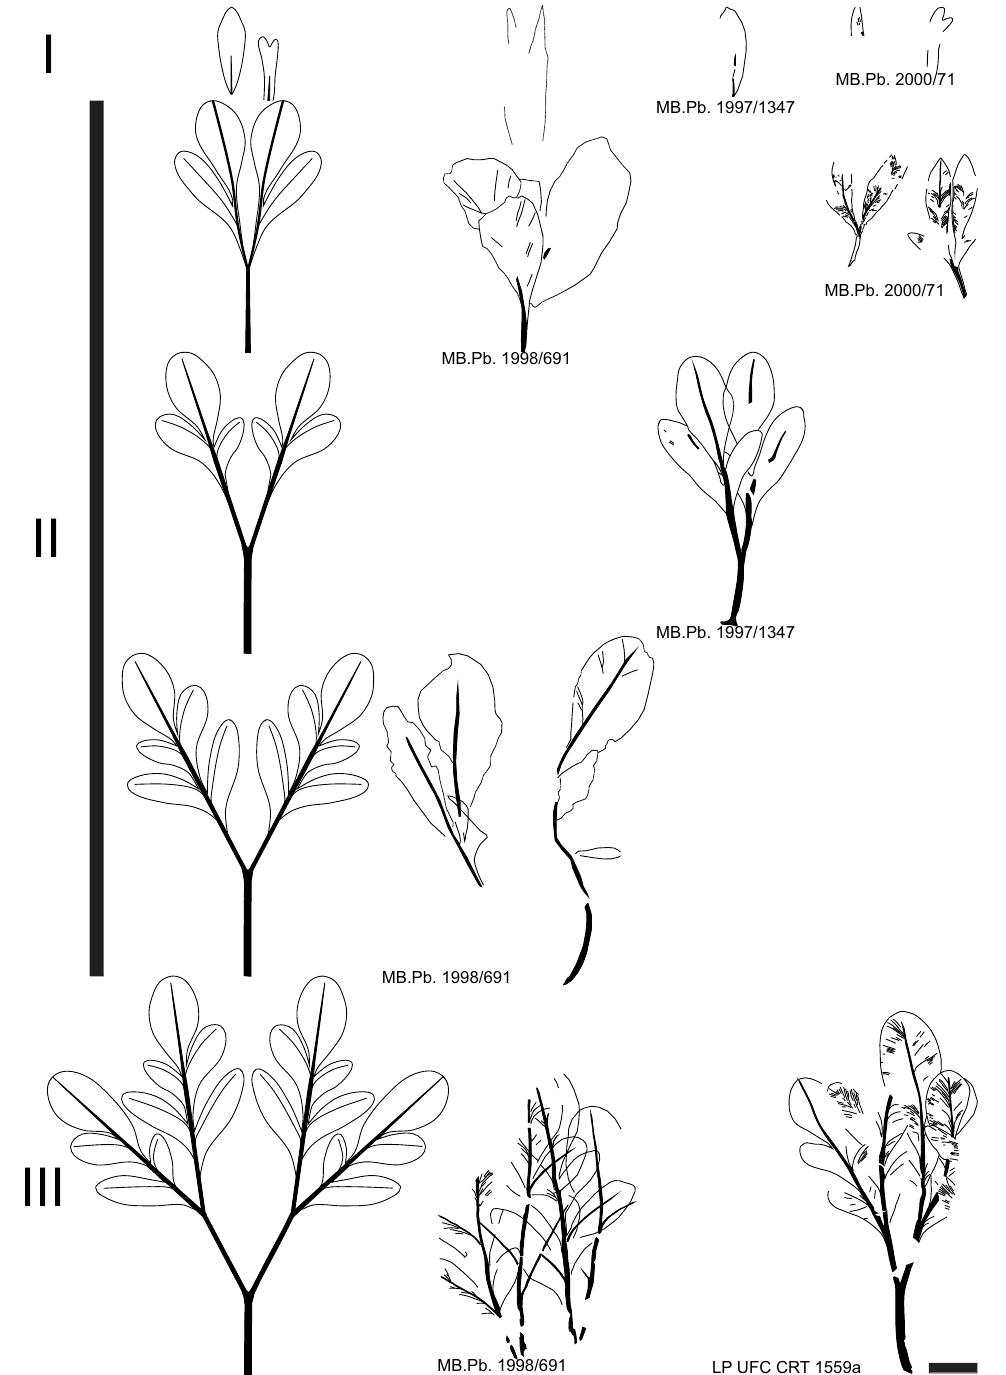
Figure 5. Line drawings of leaf type reconstructions of Santaniella gen. nov. and tentative fossil assignments. S. lobata = MB. Pb. 1998/691, MB. Pb. 1997/1347, and LP UFC CRT 1559a; S. acuta = MB. Pb. 2000/71. I, leaf type I: sessile and simple, typically last below the fruit (MB. Pb. 1998/691, MB. Pb. 1997/1347, MB. Pb. 2000/71); II, leaf type II: bifurcate, and can be interpreted as a single leaf with sessile leaflets (MB. Pb. 1998/691), or pedately compound leaves with one bifurcation into two sessile leaflets (MB. Pb. 2000/71). Larger leaves are more clearly pedately compound with distinctly petiolulate and trilobed leaflets (MB. Pb. 1997/1347). Other leaf fragments (MB. Pb. 1998/691) can be interpreted as a single leaf with two leaflets. III, leaf type III: pedately compound leaves with successive bifurcations forming four odd-pinnatisect leaflets (MB. Pb. 1998/691 and LP UFC CRT 1559a). Scale bars = 1